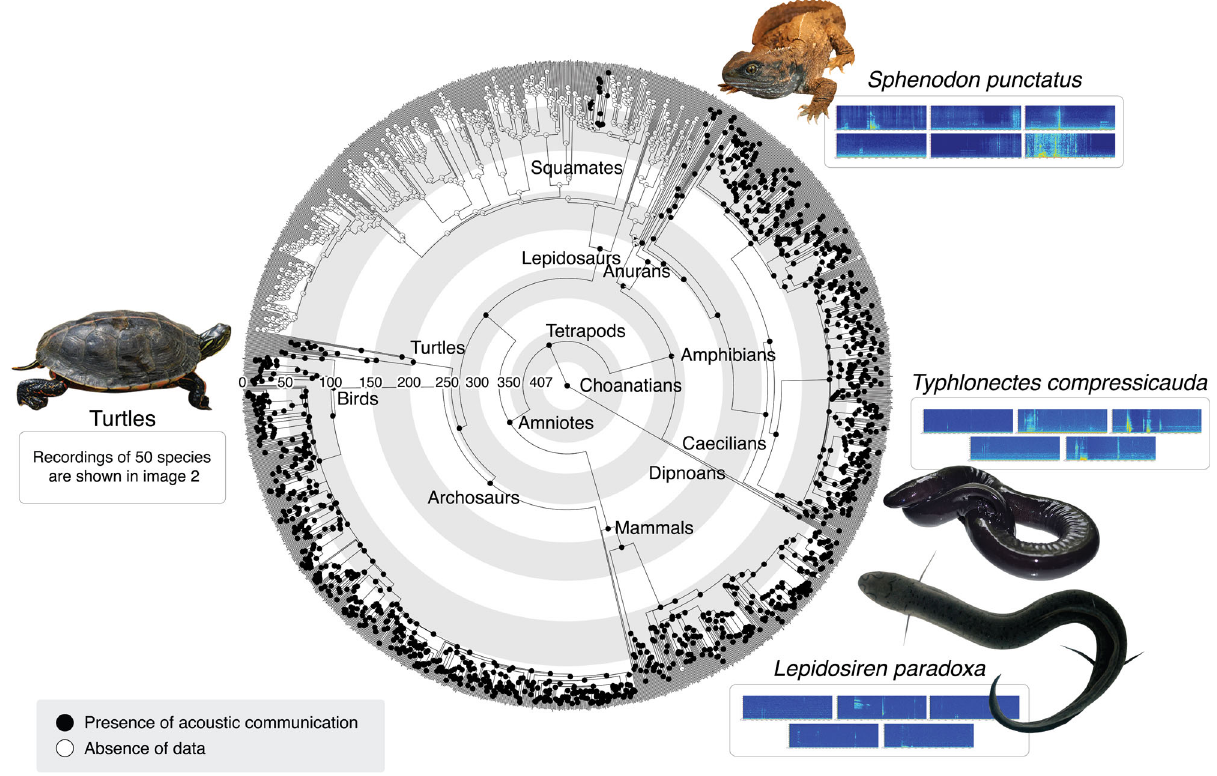
Fig. 1 | Choanate vertebrates ’ acoustic communication ancestral state recon- structionanalysis. Treeincludes1800choanatianspeciesassignedeitherwiththe character presence or absence of acoustic communication. Pie charts at ancestral nodes indicate likelihood of each character state. Colours in the spectrograms